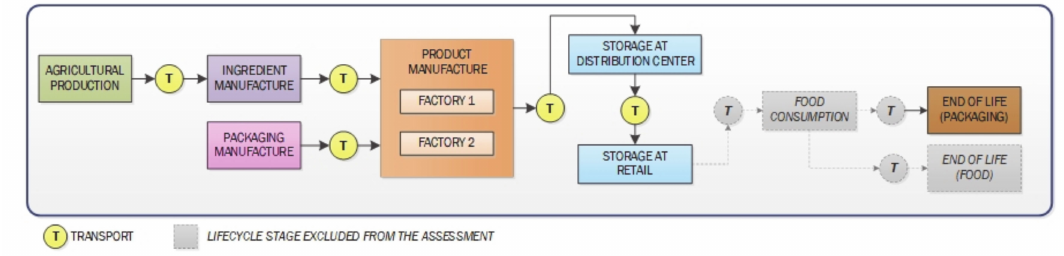
Figure 1. Scope of the study and boundaries of the breakfast cereals product